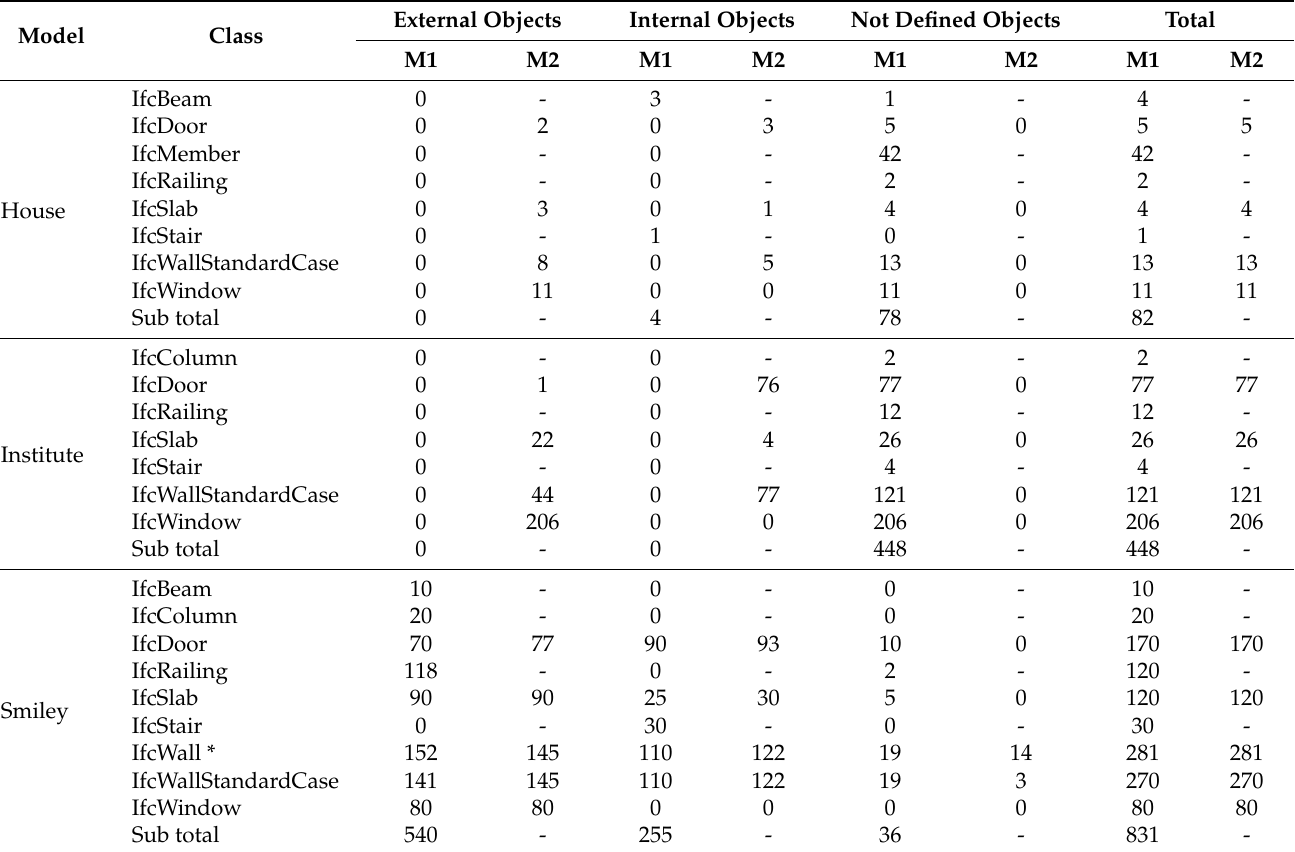
Table 10. Number of external, internal and undefined objects for each model identified by M1 and